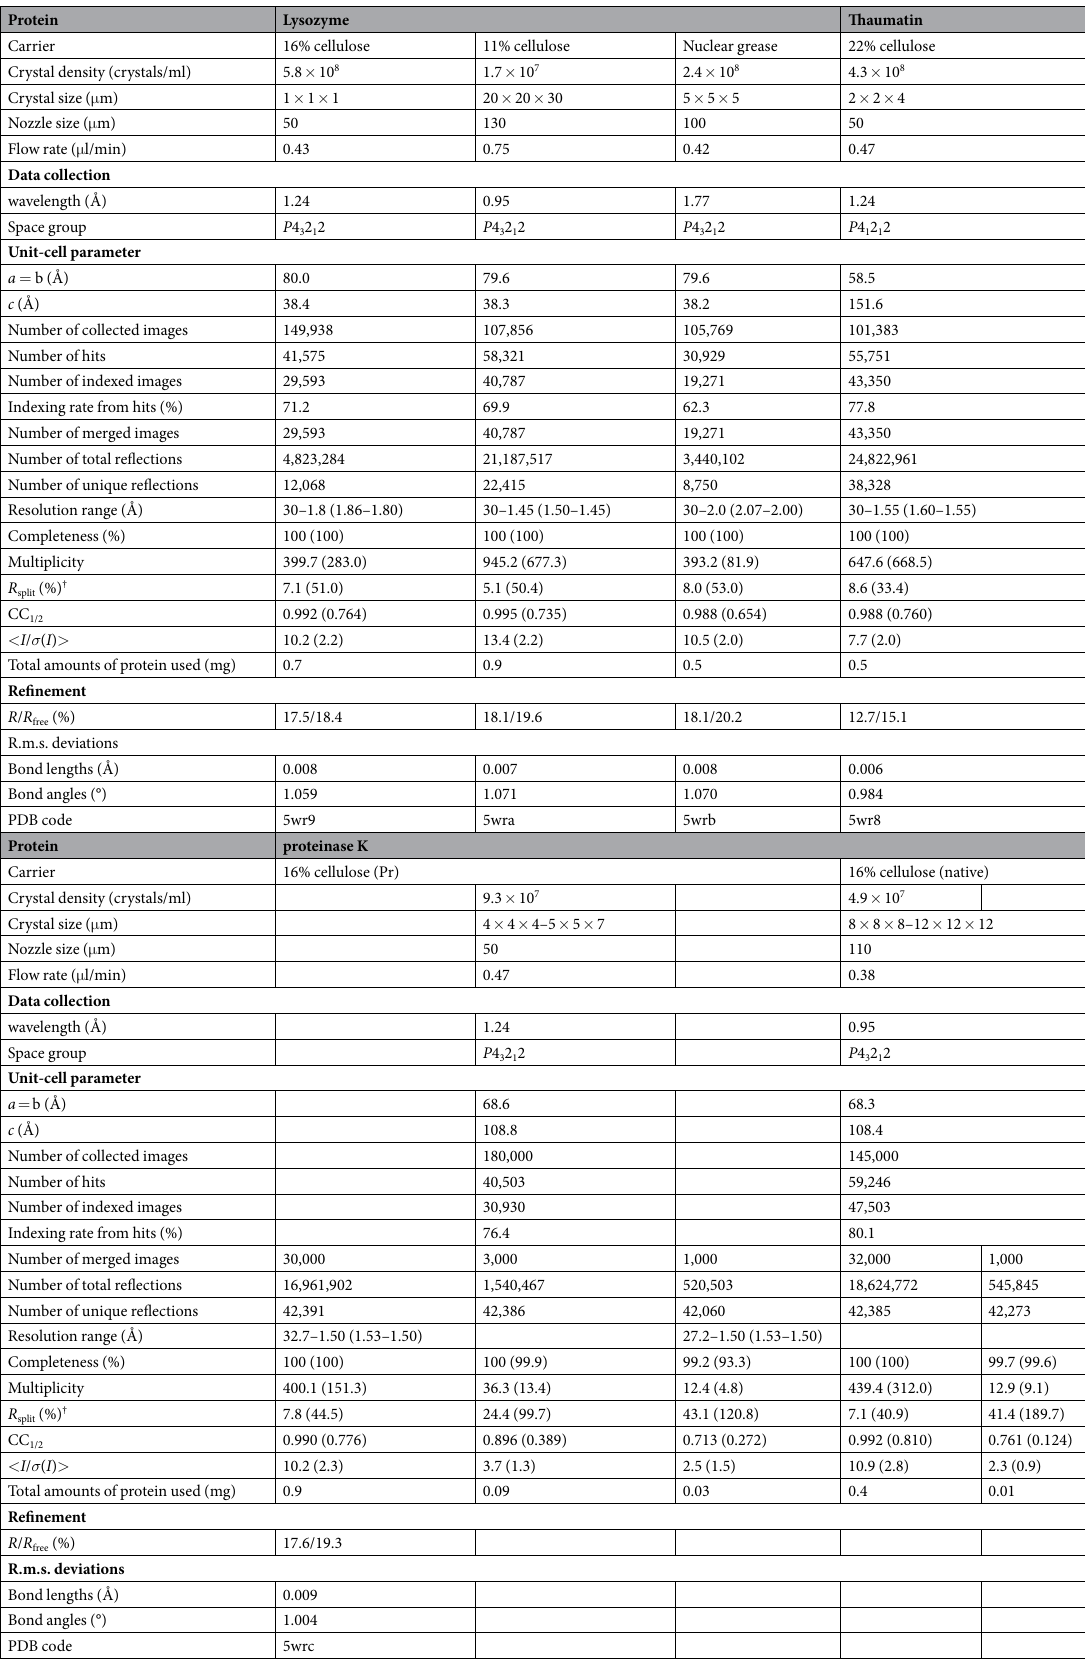
Table 1. Crystallographic statistics. Values in parentheses are for the outermost shell. †